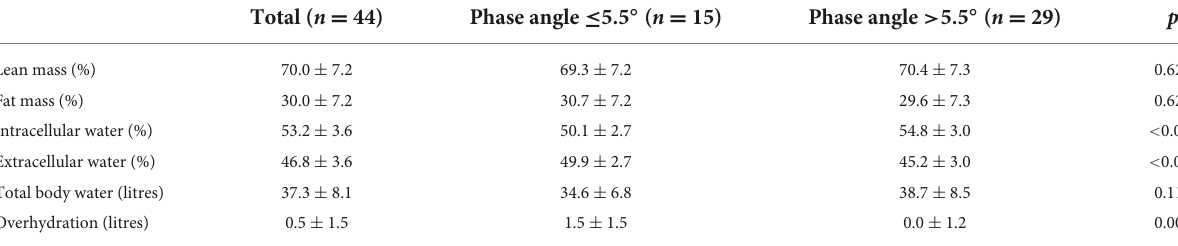
TABLE 2 Bioimpedance parameters of peritoneal dialysis (PD)